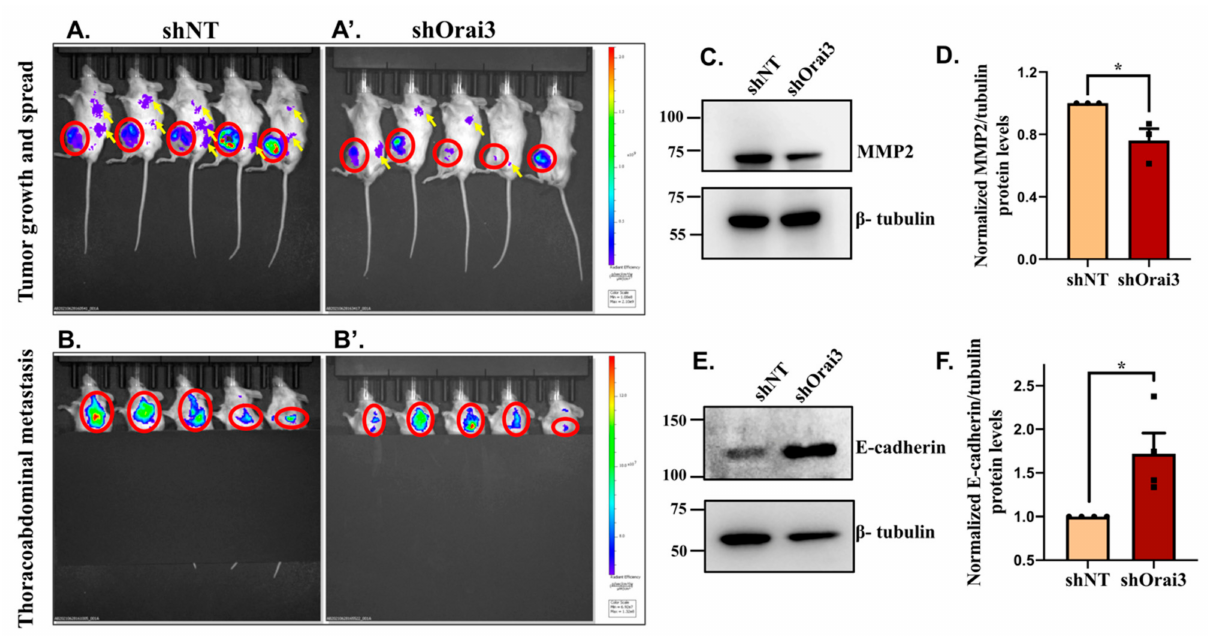
Figure 9. Orai3 regulates pancreatic cancer metastasis. ( A ) Whole-body bio-fluorescence imaging signals at 12-week post-injection timepoint in the case of shNT Panc1 stables injected mice. ( A’ ) Whole-body bio-fluorescence imaging signals in shOrai3 Panc1 stable cells injected mice at 12-week post-injection timepoint. The initial xenografts at the site of injections are marked in red circles while metastatic spread is highlighted with yellow arrows. ( B ) Thoracoabdominal region bio-fluorescence imaging signals at 12-week post-injection time-point in case of shNT Panc1 stables injected mice. ( B’ ) Thoracoabdominal region bio-fluorescence imaging signals in shOrai3 Panc1 stable cells injected mice at 12-week post-injection timepoint. The thoracoabdominal bio-fluorescence imaging signals are identified in red circles. The time interval between whole body and thoracoabdominal bio-fluorescence imaging was 3 to 5 min. ( C ) Western blot analysis for MMP2 protein expression in shNT Panc1 and shOrai3 Panc1 tumors. ( D ) Densitometric analysis of MMP2 levels in shNT Panc1 and shOrai3 Panc1 tumors. ( E ) Western blot analysis for E-cadherin protein expression in shNT Panc1 and shOrai3 Panc1 tumors. ( F ) Densitometric analysis of E-cadherin levels in shNT Panc1 and shOrai3 Panc1 tumors. Data presented as mean ± S.E.M. Un-paired t -test was performed for statistical analysis. p -value < 0.05 was considered as significant and is presented as